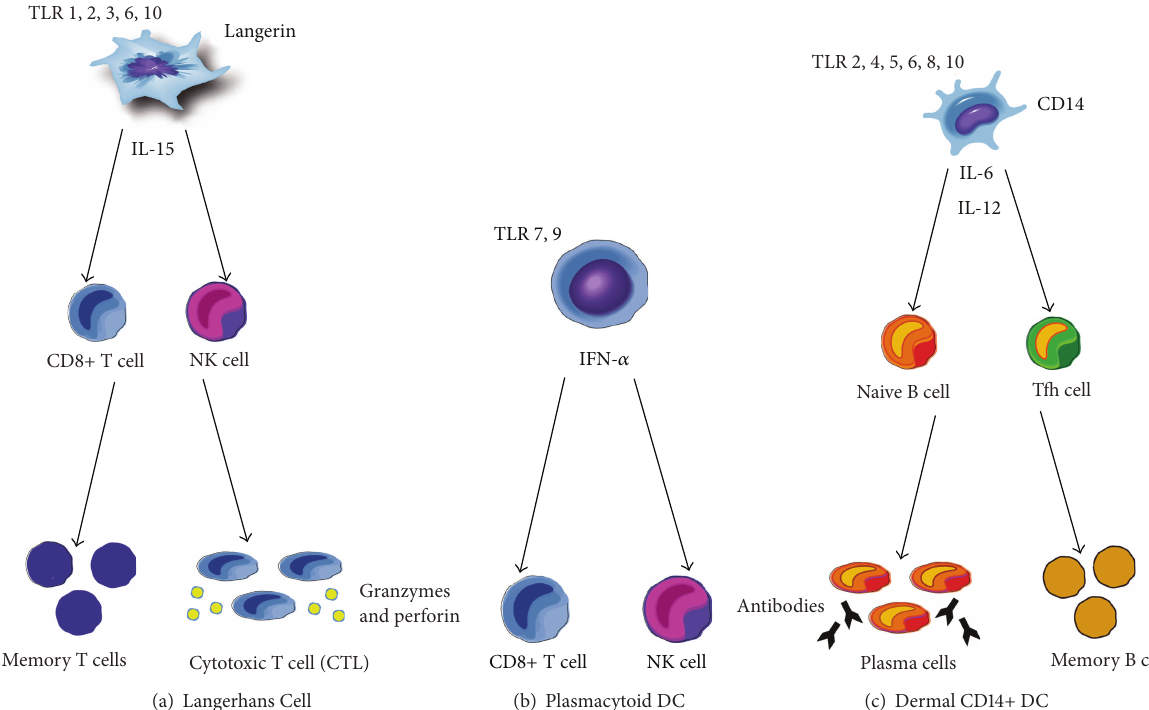
Figure 2: Different DC subsets have unique roles in shaping the immune response. (a) LCs are key mediators of cellular immunity and will preferentially activate CD8+ T cells and NK cells through the secretion of IL-15. LCs are also capable of cross-presenting foreign antigen, which results in a robust proliferation of naive CD8+ T cells and the generation of a highly specific cytotoxic T cell (CTL) response. This may contribute to the formation of immunologic memory. (b) PDCs respond to foreign antigen with the release of large amounts in IFN- 𝛼 . This serves to activate a predominantly CD8+ and NK cell response. (c) Dermal CD14+ DCs are critical in the regulation of humoral immunity. When activated, they secrete IL-6 and IL-12, which promotes IgM secretion from naive B cells and the generation of mature antibody-secreting plasma cells. IL-12 will also trigger the differentiation of T follicular helper cells (Tfh) from CD4+ T cells, which may contribute to the formation of memory B